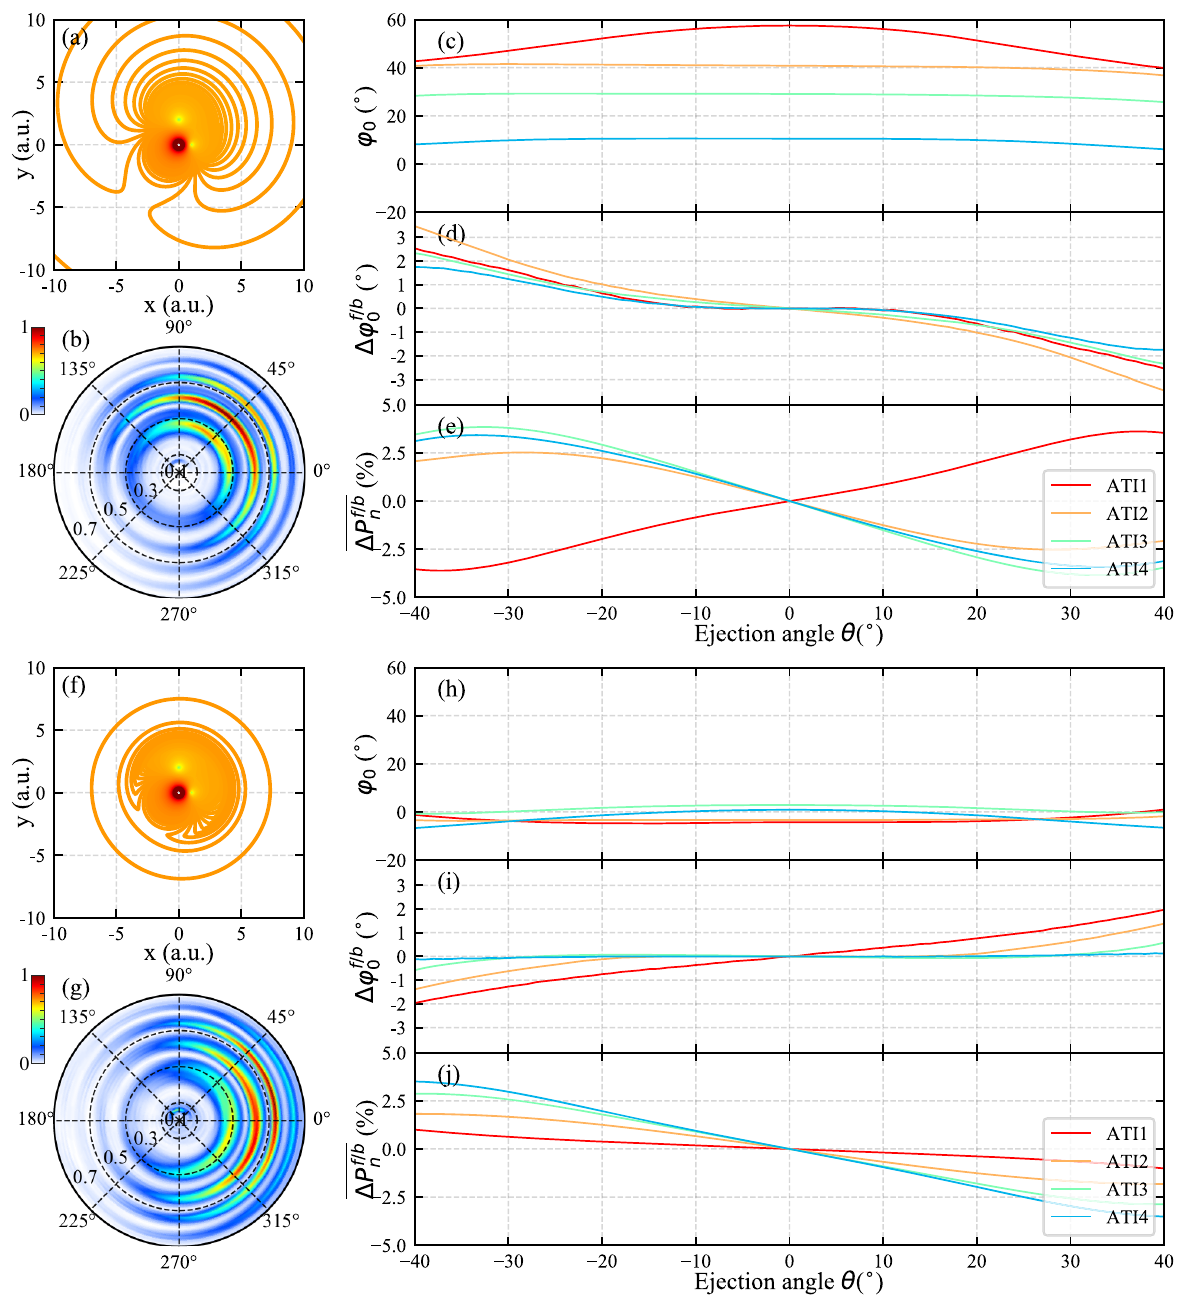
FIG. 3. Chiral attoclock TDSE calculations in a toy-model chiral molecule, using an 800- and 400-nm bicircular field with I ω ¼ 2 × 10 13 W · cm − 2 and r ¼ 0 . 1 . (a) Potential of the toy-model molecule in the θ ¼ 0 plane. (b) Photoelectron angular distribution in the laser polarization plane ( θ ¼ 0 ). The radius is the photoelectron momentum in a.u. (c) Attoclock streaking angle φ 0 ð θ Þ of the first four ATI peaks (from red to blue) as a function of the electron ejection angle θ . (d) Forward-backward asymmetry in the attoclock streaking angles Δ φ f=b 0 ;n . (e) Forward-backward asymmetry in the intensity of the first four ATI peaks (from red to blue). (f) – (j) are the same as (a) – (e) but relative to a Yukawa-screened